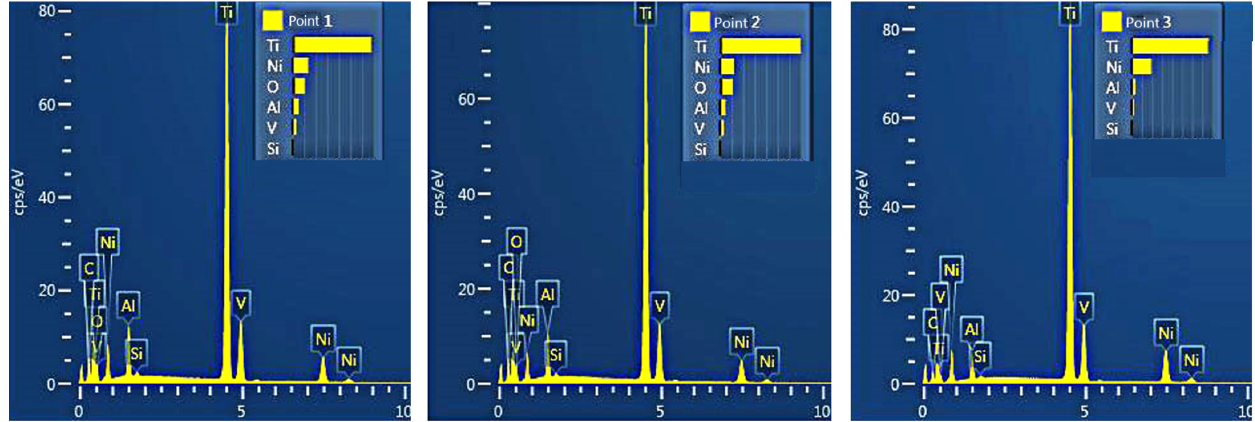
Figure 12. EDS analysis results of wear debris in Figure